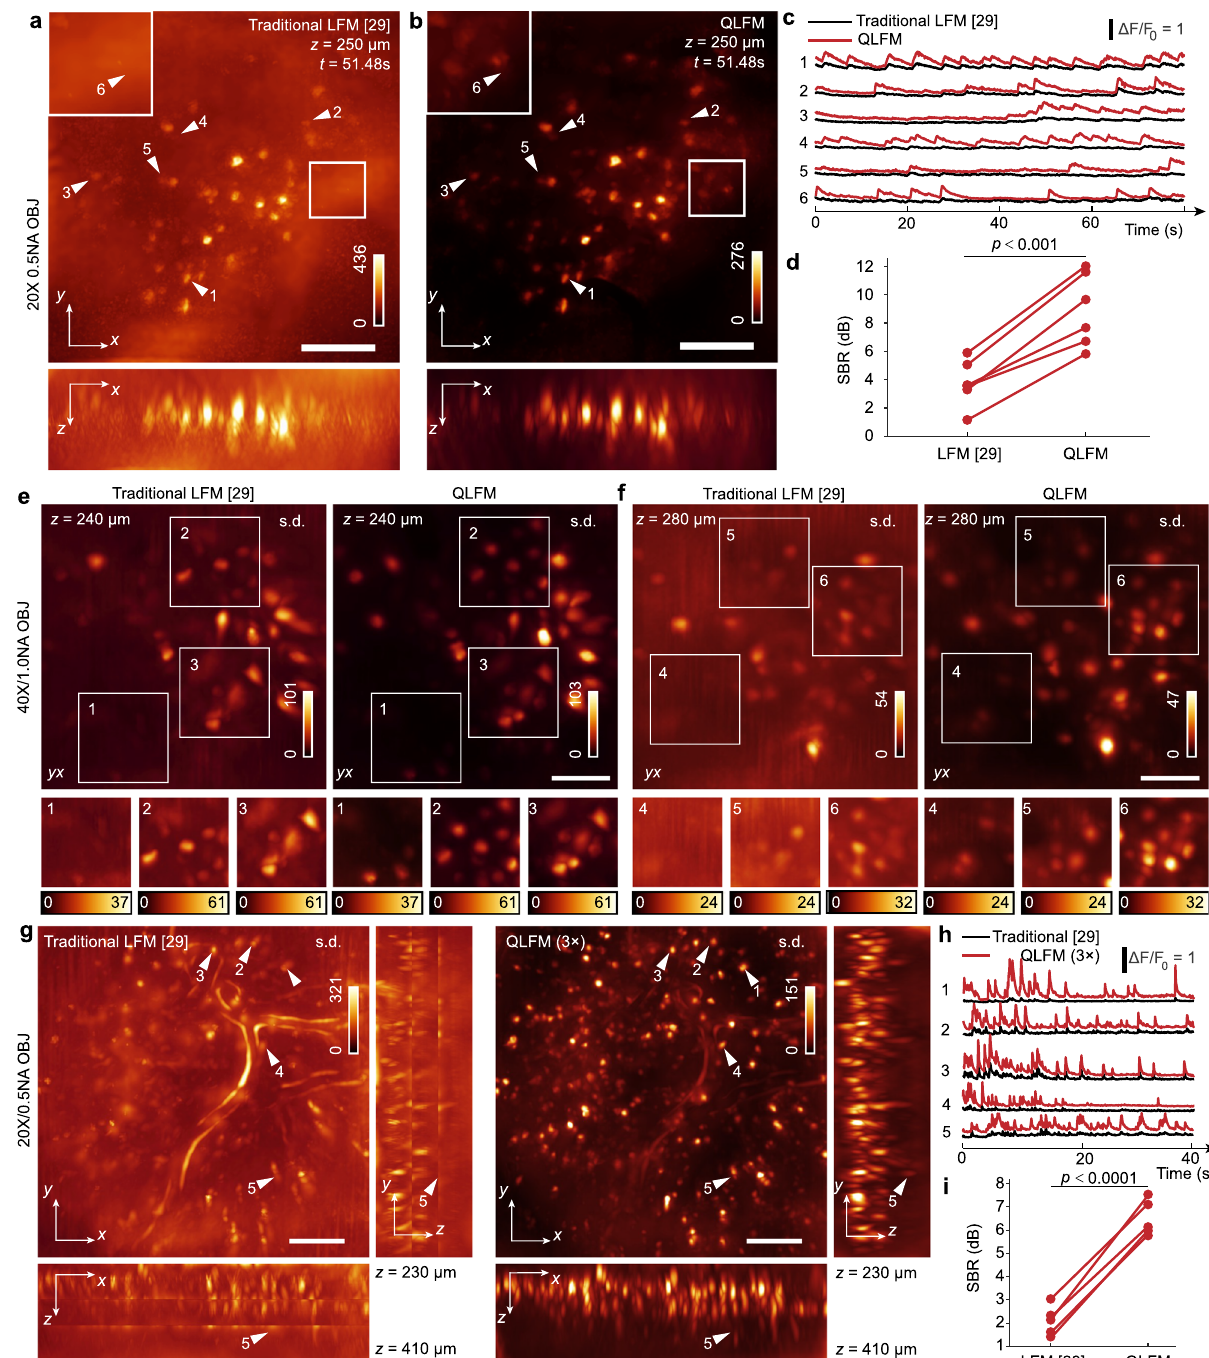
Fig. 5 3D functional imaging in awake mouse brains. a , b Orthogonal MIPs of GCaMP6s-labeled neurons at t = 51.48 s reconstructed by traditional LFM and QLFM with a ×20/0.5NA objective, indicating the reduced background with computational optical sectioning (Supplementary Movie 4). More neurons were revealed by QLFM in the mouse cortex with the native objective plane at a depth of ~250 μ m. c Temporal traces of the marked neurons in a and b , demonstrating the quantitative calcium responses in QLFM with improved contrast. d Scatter diagram of SBR of each neuron marked in a and b by different methods. Data points from the same neuron obtained by traditional LFM and QLFM are connected by a red line. P value was calculated by the paired, two- tailed t -test ( α = 0.05). e , f Orthogonal MIPs of the standard deviation across 2000 volumes imaged at a center depth of 240 μ m and 280 μ m in the cortex, respectively, under a ×40/1.0 NA water-immersion objective (Supplementary Movie 5). g Orthogonal MIPs of the standard deviation across 500 volumes for GCaMP6f-labeled L2/3 neurons in awake behaving mice. The video was captured with high-speed axial scanning at a step of 50 μ m for three planes under a ×20/0.5 NA objective. h Temporal traces of several marked neurons at different depths. i Scatter diagram of SBR for fi ve selected neurons in g . Data points from the same neuron obtained by traditional LFM and QLFM are connected by a red line. P value was determined via the paired, two- tailed t -test ( α = 0.05). Source data are provided as a Source data fi le. Scale bars, 100 μ m ( a , b , g ) and 50 μ m ( e , f ).